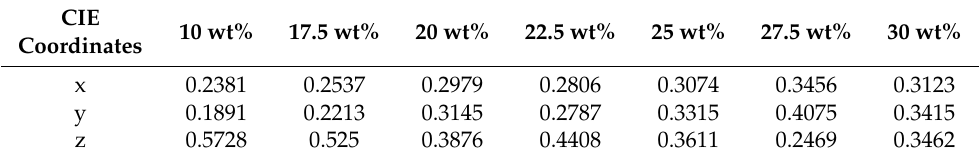
Table 3. CIE coordinates verse phosphor concentration of